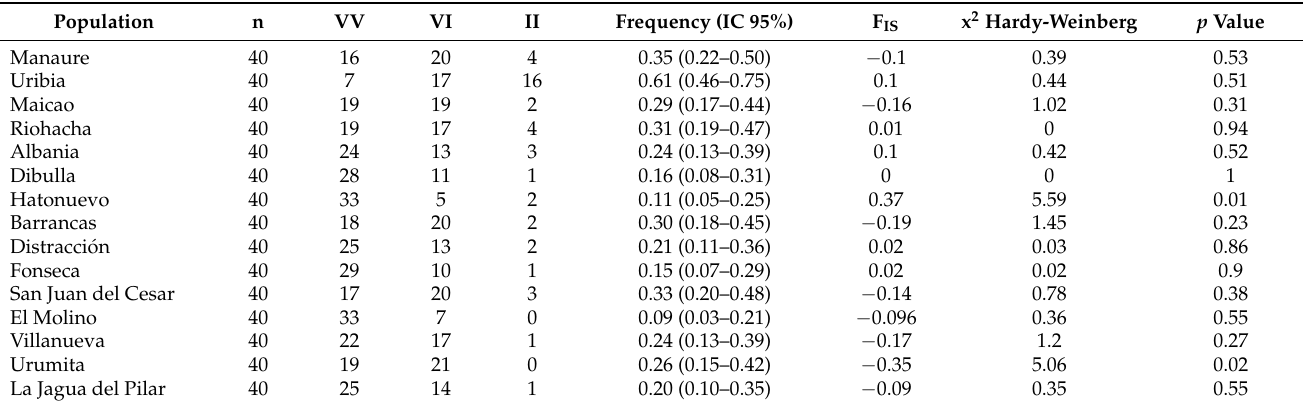
Table 2. Allele and genotype frequencies of V1016I in populations of Ae. aegypti from La Guajira, Colombia.